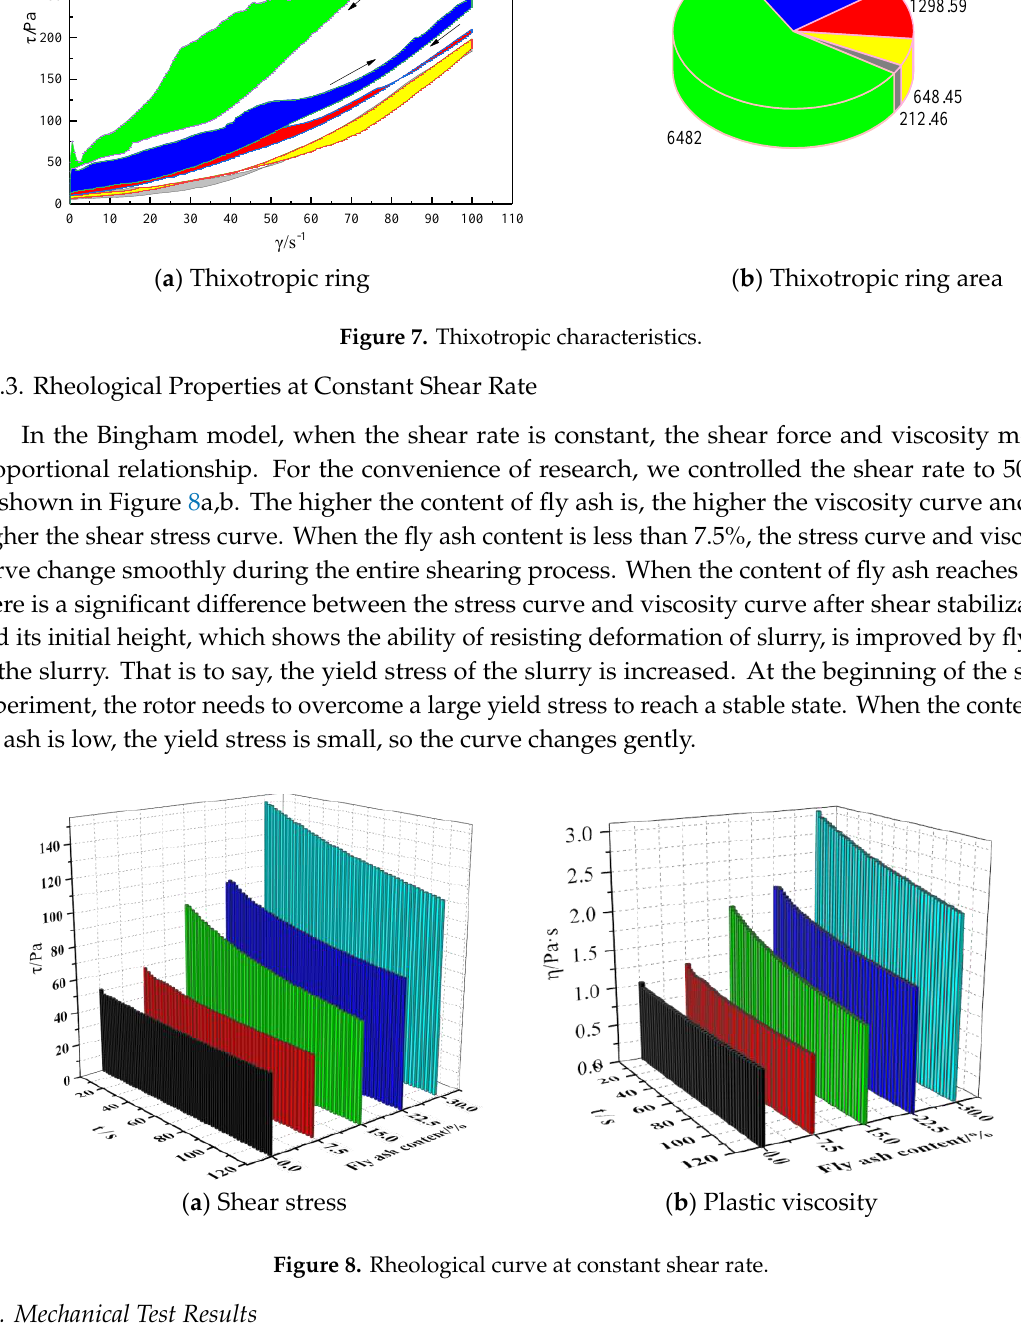
Figure 7. Thixotropic characteristics.